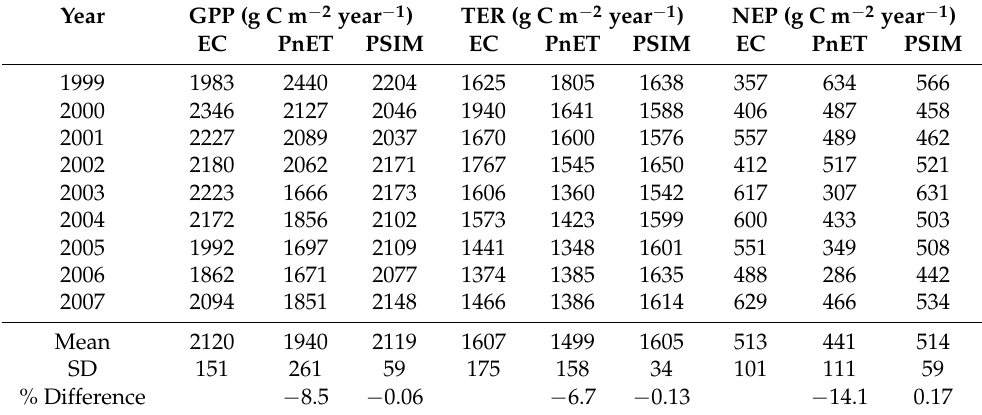
Table 4. Annual CO 2 fluxes for 1999–2007 at the Straits Inclosure measured by eddy covariance and simulated by PnET and PSIM. ‘%Difference’ is the percentage difference between the mean annual simulated and measured